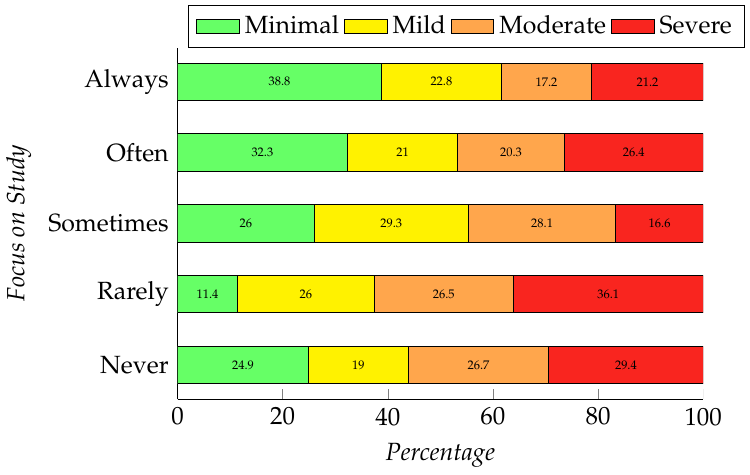
Figure 2. Relation between students’ focus on study and their level of anxiety. We have found a significant relationship between a student’s sleep time and mental health through the chi-square test (depression, χ 2 (8, N = 409) = 20.564, p = 0.008 and anxiety, χ 2 (6, N = 409) = 7.294, p = 0.295). The participants who have been sleeping for more than nine hours, which is greater than the recommended average time [56], are suffering from poor mental health. However, the participants who are maintaining the average sleep time, which is 7–9 h per day, are suffering less from depression. The participants who are not having sufficient sleep are also facing some issues of depression (see Figure 3). Using the chi-square test, we have found a dependency between the time spent on personal care and the anxiety level of the students (depression, χ 2 (8, N = 409) = 8.933, p = 0.348 and anxiety, χ 2 (6, N = 409) = 14.862, p = 0.021). Participants having all levels of anxiety (except mild anxiety) are spending more than 4 h each day on taking care of themselves (see Figure 4). As participants are spending more time at home, they are spending more time than before on personal care. However, we did not find any dependency between participants’ level of depression and personal